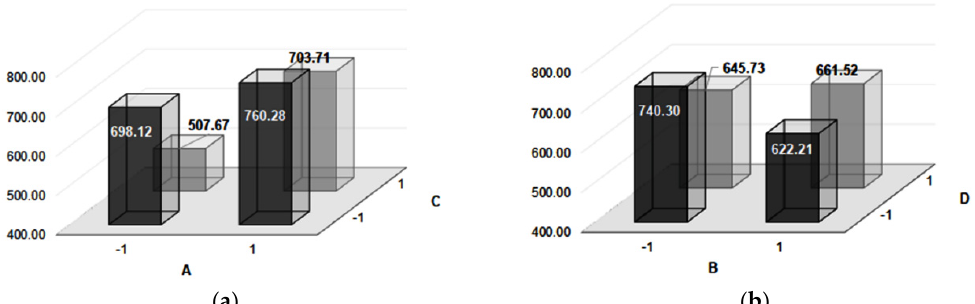
Figure 8. Analysis of interactions with a significant effect with respect to the hardness of the constituent matrix. X-axis represents the two levels of A-factor (figure ( a )) and the two levels of B-factor (figure ( b )). Y-axis represents the two levels of C-factor (figure ( a )) and the two levels of D-factor (figure ( b )). Z-axis represents the effect of each possible combination: ( a ) interaction AC; ( b ) interaction